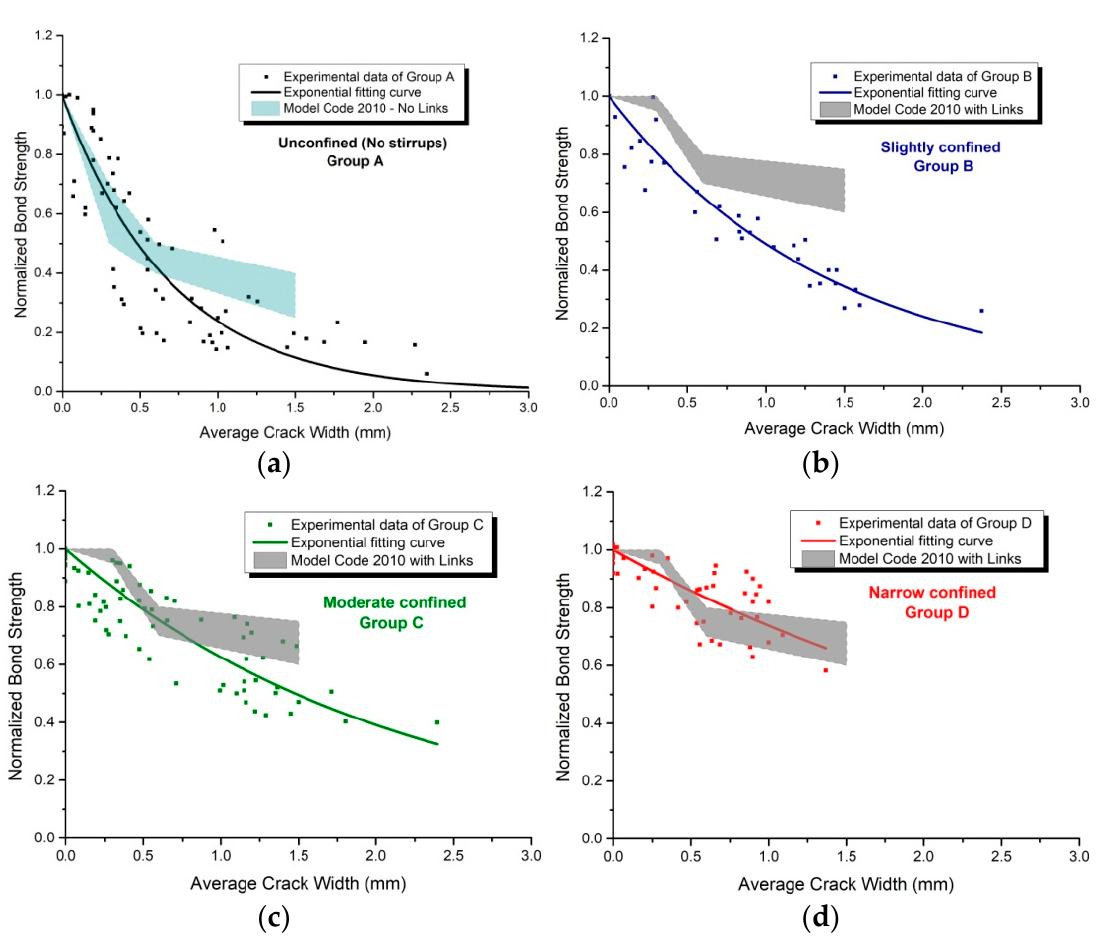
Table 5. Parameters determined by regression analysis for the exponential predictive model.